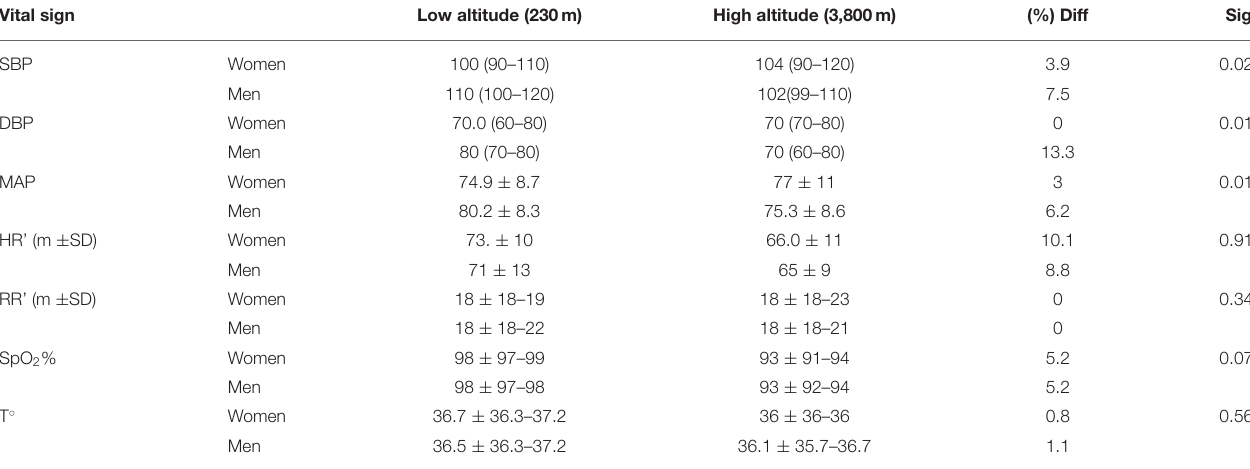
TABLE 2 | Description of the main vital signs of both populations including arterial blood pressure, heart and respiratory rate, temperature, and blood peripherical oxygen saturation. Vital